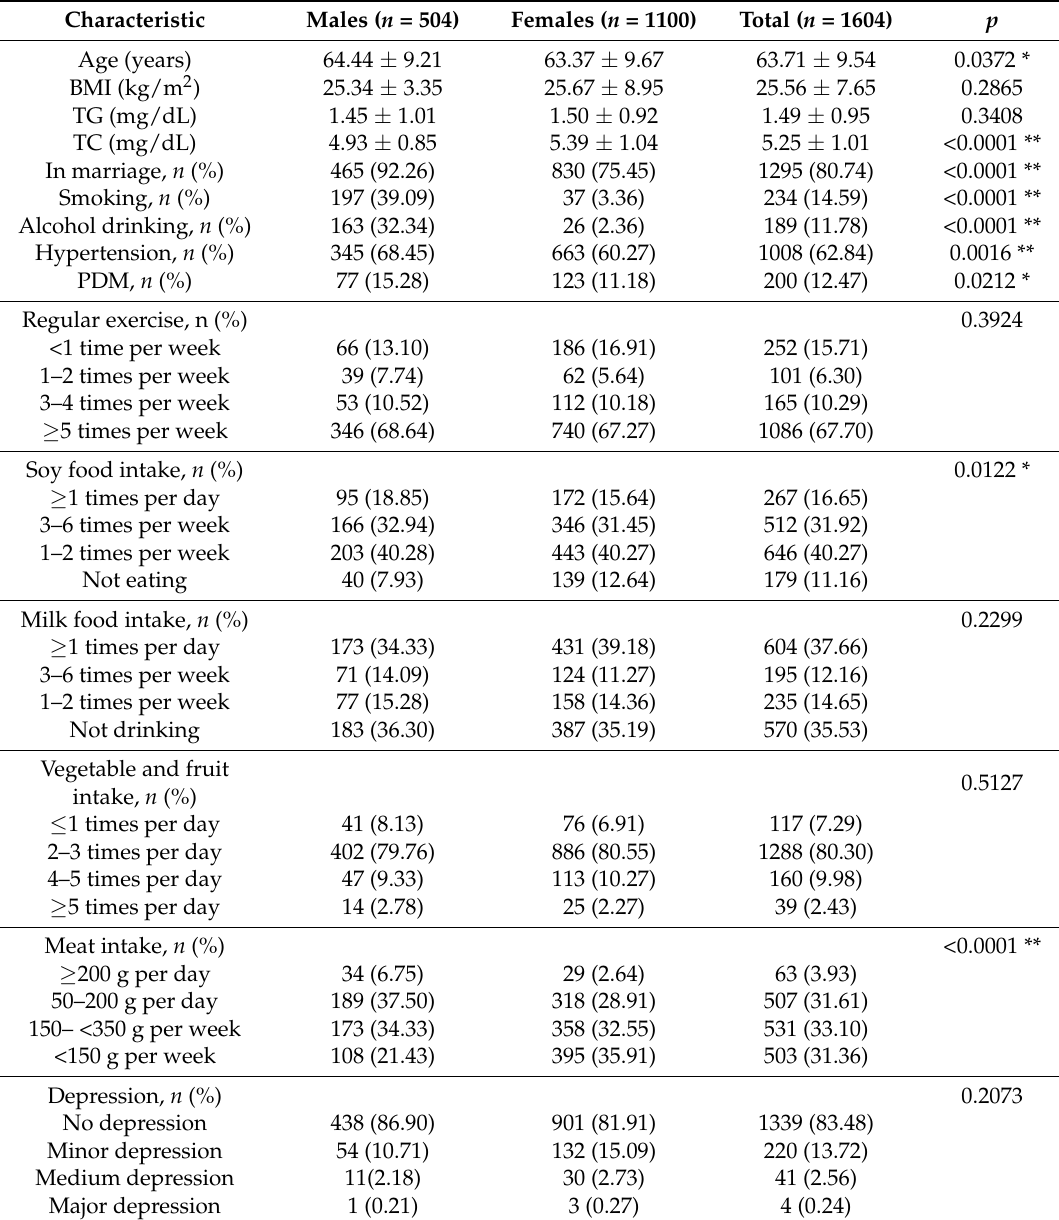
Table 1. Summary statistics and comparison of characteristics according to gender (means ±